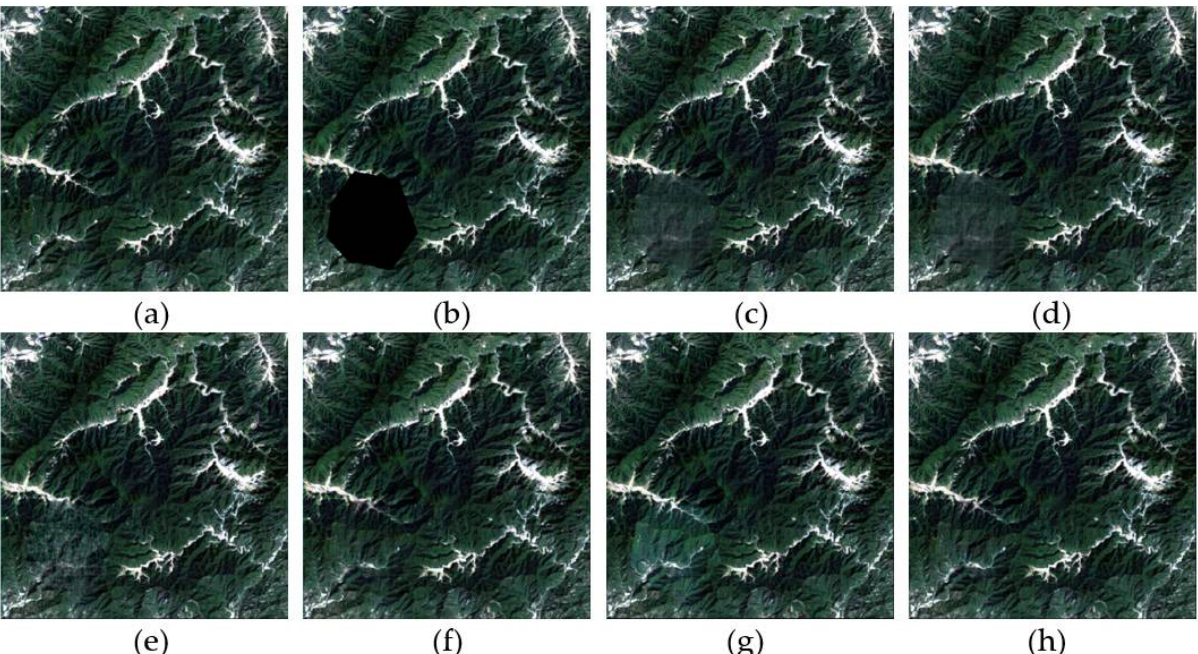
Figure 8. Enhanced details from Figure 7a–h: ( a ) original image; ( b ) simulated cloudy image; ( c – h ) reconstructed images of HaLRTC, AWTC, NL-LRTC, TVLRSD, ST-Tensor and FMTC algorithms, respectively.